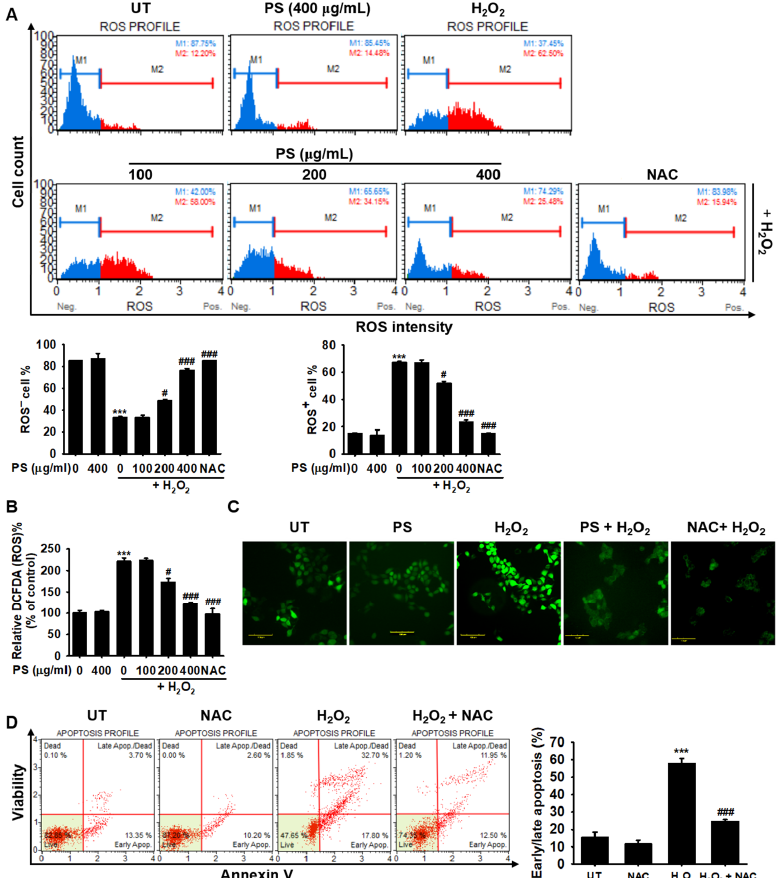
Figure 4. PS attenuates intracellular ROS generation in H 2 O 2 -treated HaCaT keratinocytes. HaCaT keratinocytes were seeded at a density of 1 × 10 4 cells / mL and then stimulated with the indicated concentrations of PS (0–400 µ g / mL) for 20 h prior to treatment with 1000 µ M H 2 O 2 for 4 h. N -Acetylcysein (NAC, 5 mM) was used as the negative control. ( A ) Intracellular ROS generation was measured by flow cytometry using a Muse ® Oxidative Stress Kit. Mean percentages of ROS − (M1; blue) and ROS + (M2; red) populations are shown. ( B ) HaCaT keratinocytes were seeded and 10 µ M 2 (cid:48) 7 (cid:48) -dichlorofluorescein diacetate (DCFDA) was then added to the cells. DCFDA fluorescence intensity was calculated by using a fluorometer and compared with that in the untreated group. ( C ) Live imaging stain using DCFDA was performed using a CELENA ® S digital imaging system. ( D ) In a parallel experiment, HaCaT keratinocytes were pretreated with 5 mM NAC 2 h before treatment with H 2 O 2 for 4 h. Then, the early / late apoptosis populations were measured by flow cytometry using Muse ® Annexin V & Dead Cell Kit. The early / late apoptotic population is presented as a bar graph. All data are averaged from three independent experiments and presented as mean ± the standard error of the median [*** p < 0.001 vs. the untreated group (UT) and ### p < 0.001 and # p < 0.05 vs. the H 2 O 2 -treated group]. Scale bars